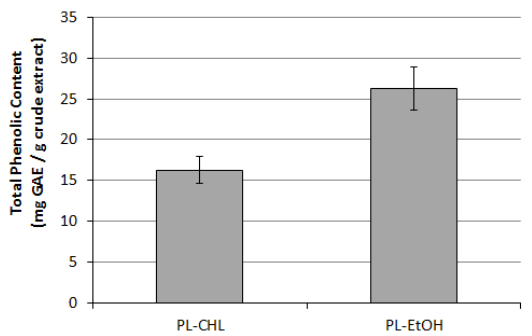
Figure 2. Total Phenolic Content of chloroform (CHL) and ethanol (EtOH) extracts of C. colocynthis plantlets. Values are expressed as mg of gallic acid equivalents (GAE)/g of extract ± S.D. (vertical bars; p < 0.005).